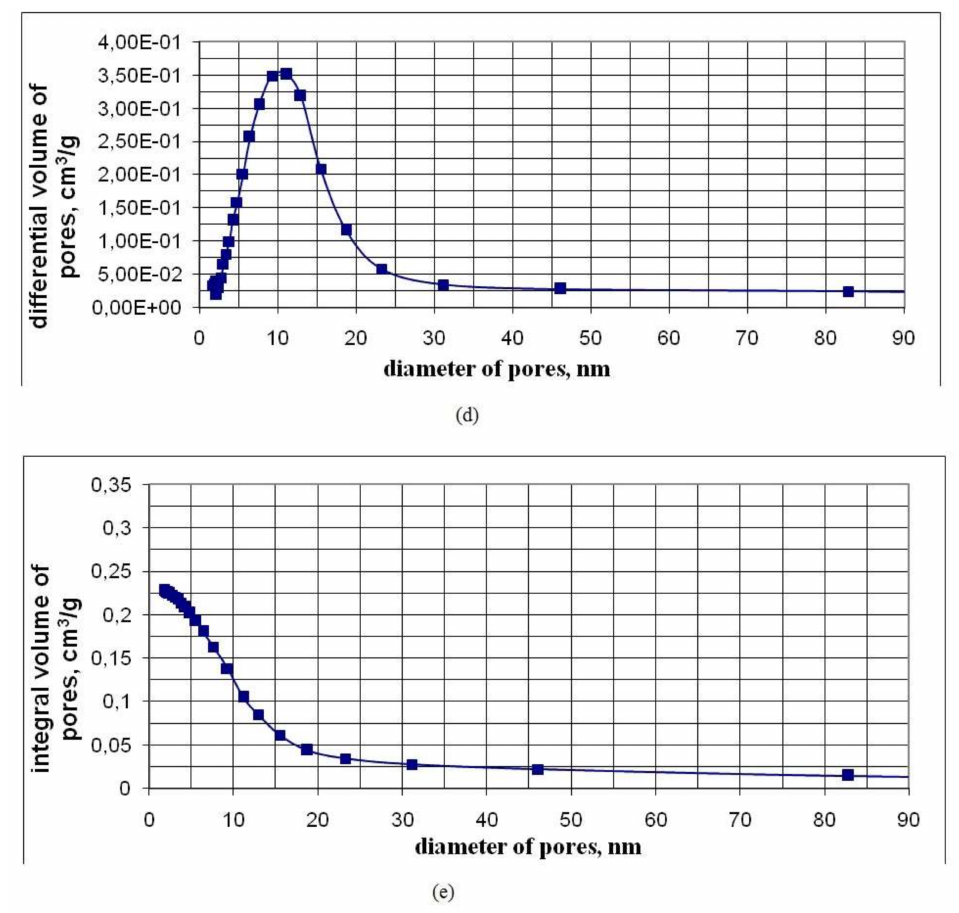
Figure 10. Pore characteristics of the UF-6-26 sample obtained by the low-temperature nitrogen adsorption method: ( a ) adsorption-desorption curves (p / p 0 —relative nitrogen pressure, p 0 —nitrogen saturation pressure at a temperature of 77 K); ( b ) di ff erential distribution of area over pore diameter; ( c ) integral distribution of the area along the pore diameter; ( d ) di ff erential distribution of volume over pore diameter; ( e ) integral distribution of volume by pore